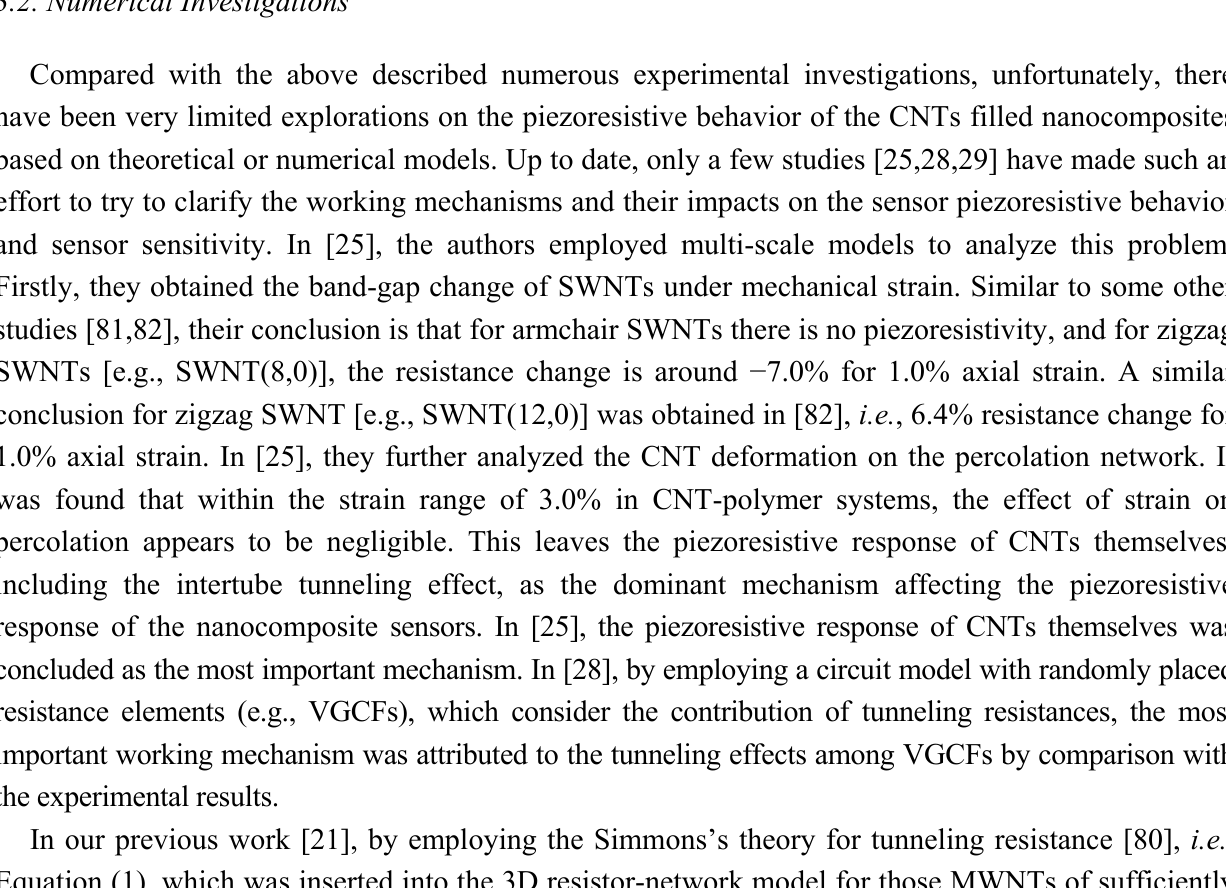
Figure 21. Modeling of tunneling resistance in a resistor network. Tunneling J